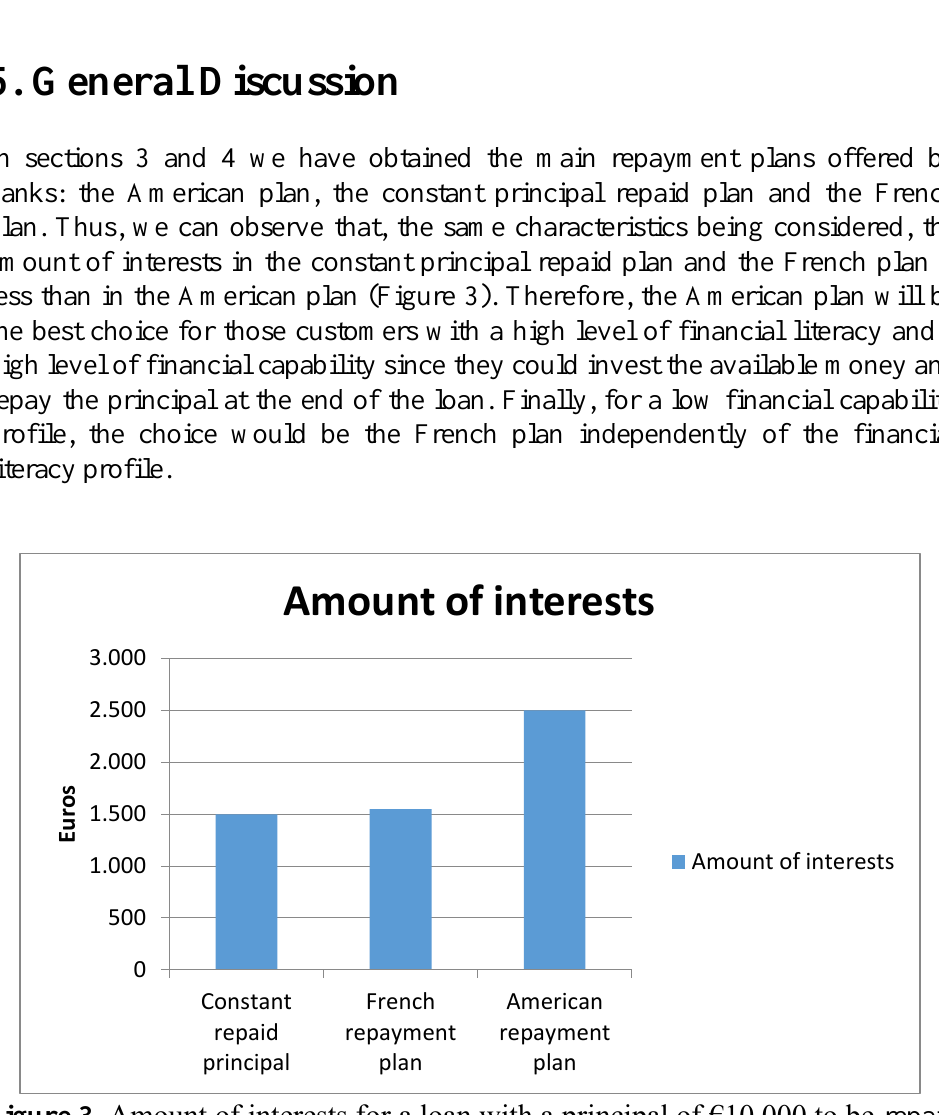
Figure 3 . Amount of interests for a loan with a principal of €10,000 to be repaid in 5 years at a 5% interest